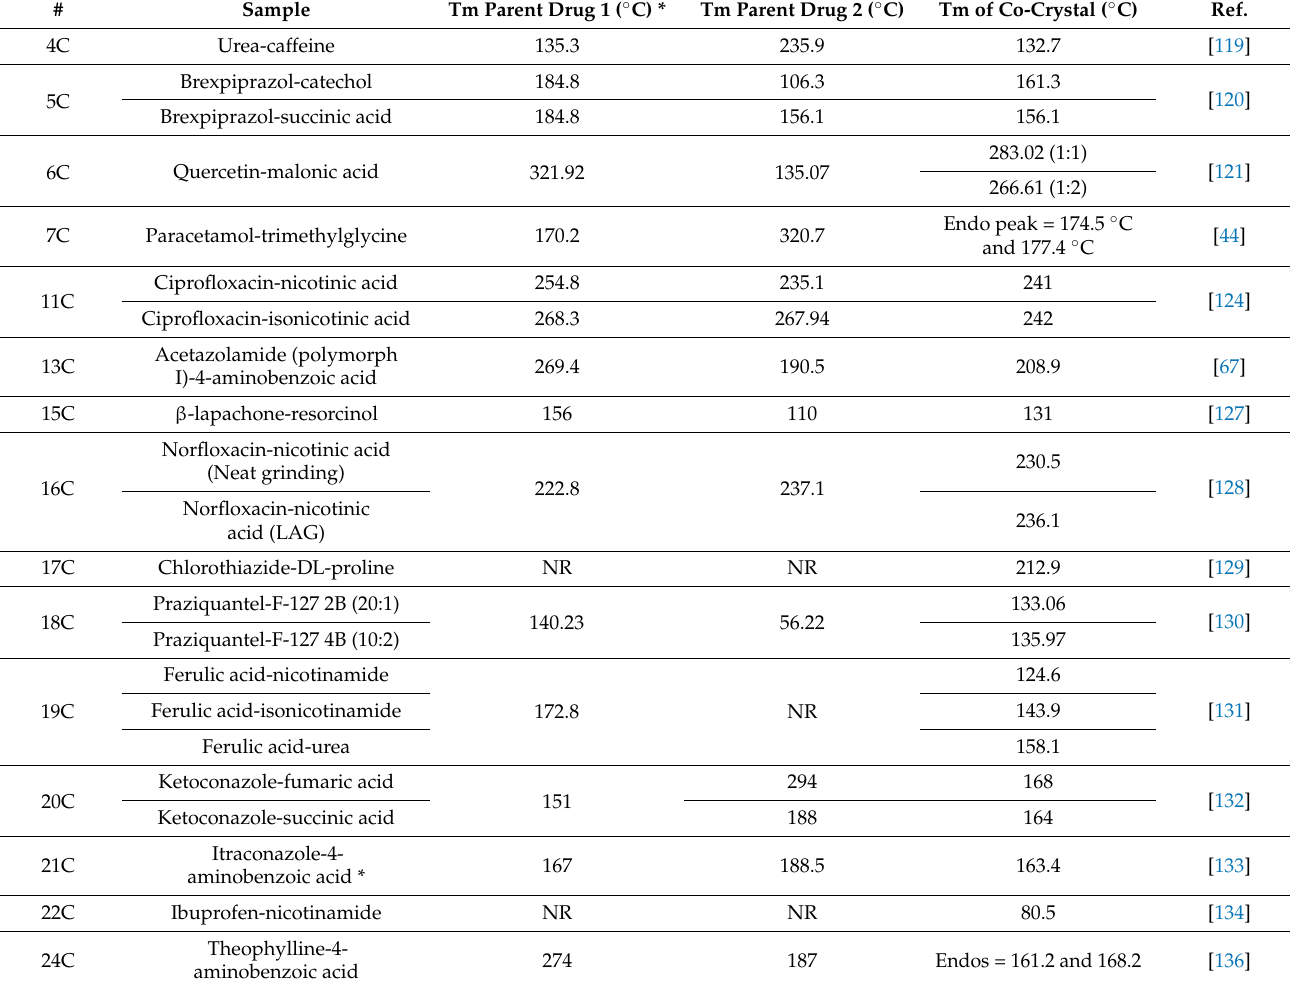
Table 10. Overview of thermal characterization (DSC) of drug co-crystals obtained by ball